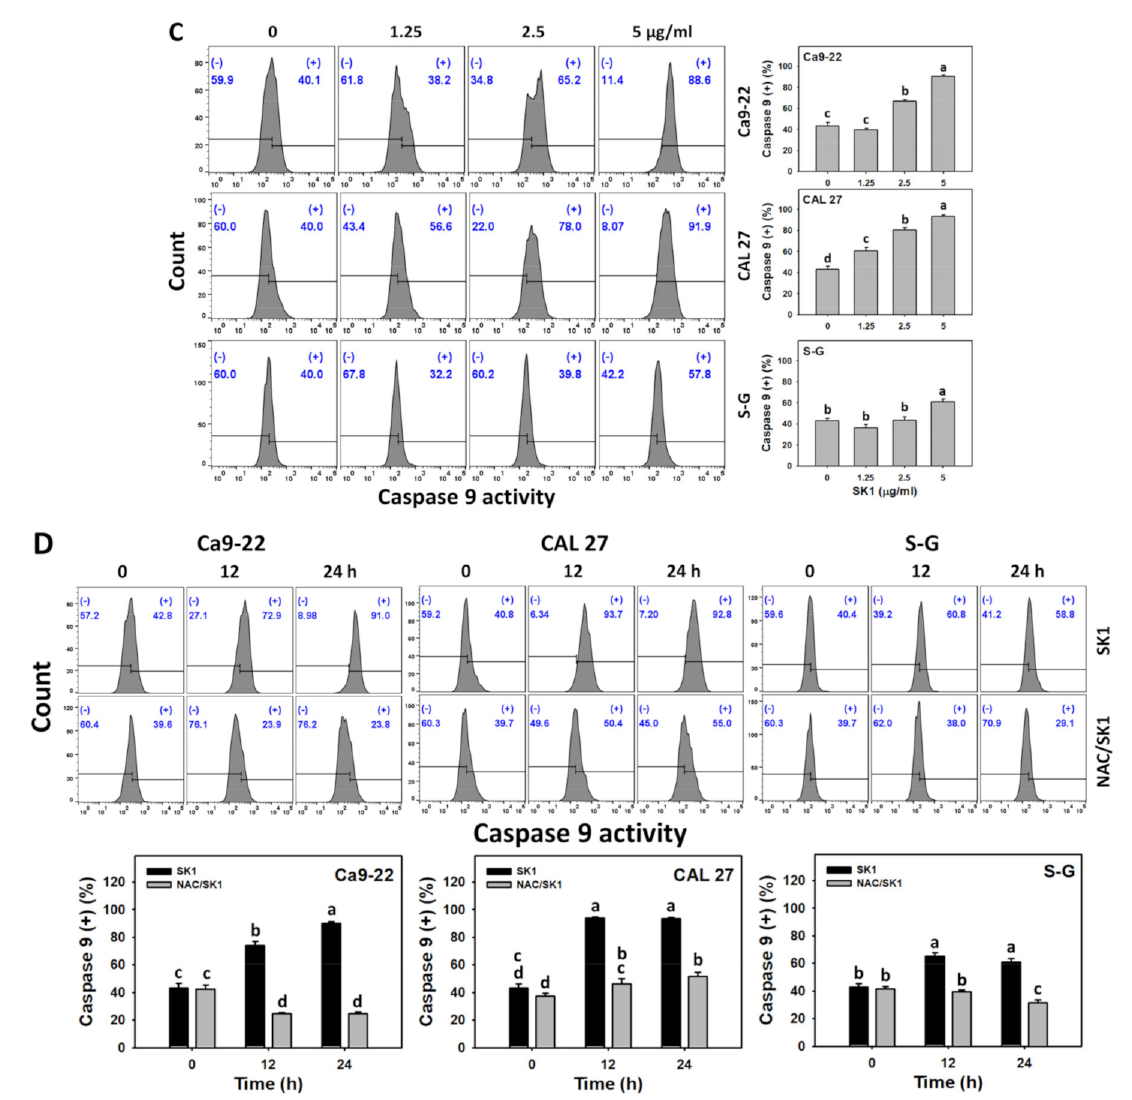
Figure 5. Apoptosis effects (Caspase 8 and 9) of SK1. ( A , C ) Caspase 8 and caspase 9 assays of SK1. Non-malignant (S–G) and oral cancer (Ca9-22 and CAL 27) cells were treated with SK1 (0 (0.1% DMSO in medium), 1.25, 2.5, and 5 µ g/mL) for 24 h. ( B , D ) Caspase 8 and caspase 9 assays of NAC/SK1. NAC/SK1 indicated that cells were pretreated with NAC and posttreated with SK1 5 µ g/mL for 0, 12, and 24 h. (+) inserted at the histogram is counted for the percentage of caspase 8 or caspase 9 (+)(%). Data, mean ± SD ( n = 3). Statistical software provided non-overlapping low-case letters indicate significant results for multi-comparison ( p <